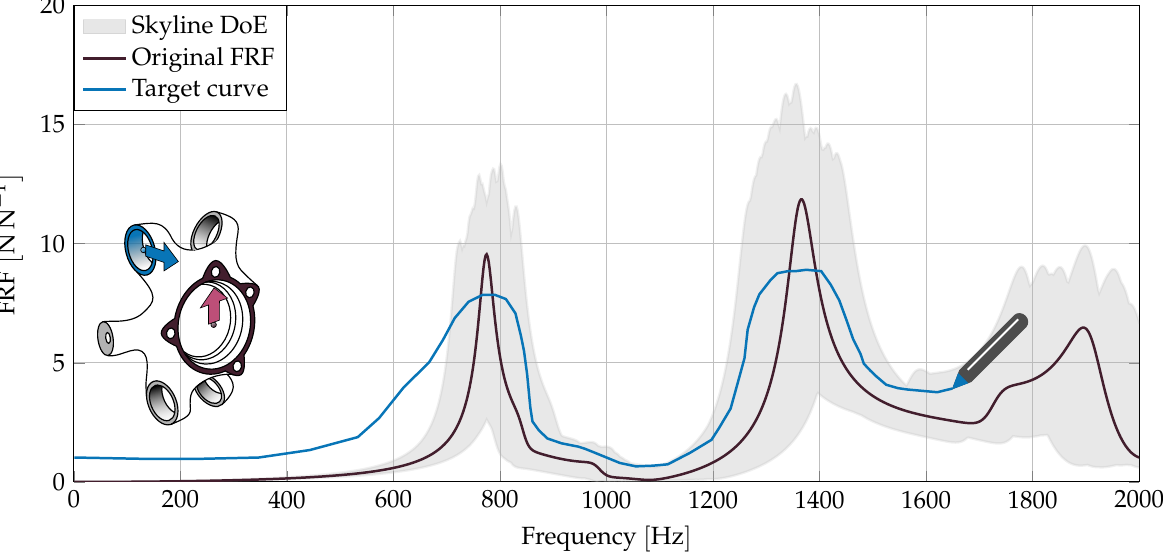
Figure 3. User input for the creation of a target curve. A graphical application presents the original FRF (black) and the skyline of all FRFs of the DoE data set (gray). The design engineer draws (pen symbol) a desired target curve into the plot